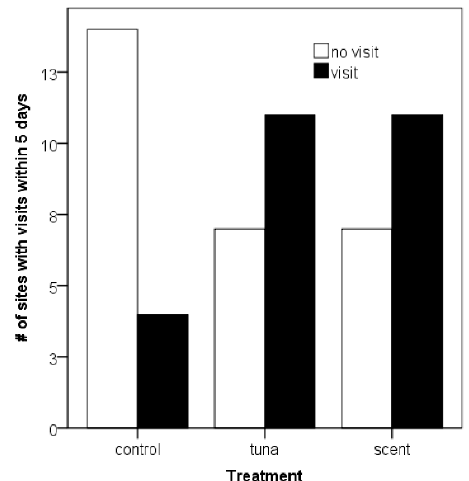
Figure 1. Naïve occupancy (detection probability during the experimental period) of martens at 54 locations dependent on the experimental treatment (tuna or scent) and the control. A total of 18 sites was applied per treatment.